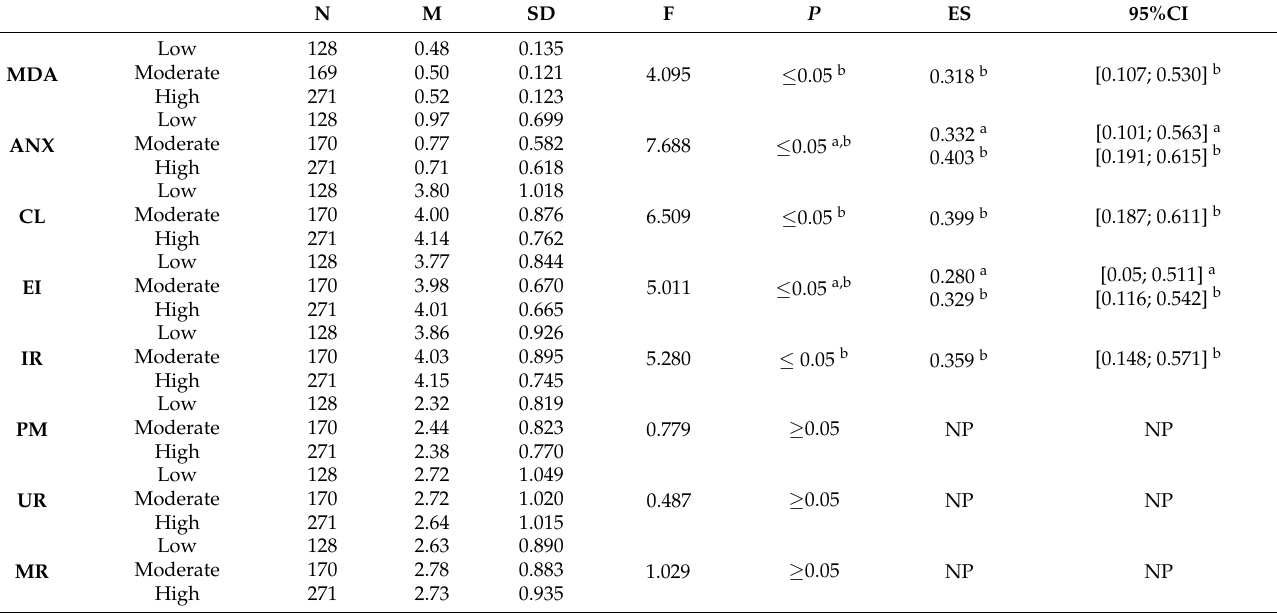
Table 1. Comparative study of the sample in terms of weekly physical activity